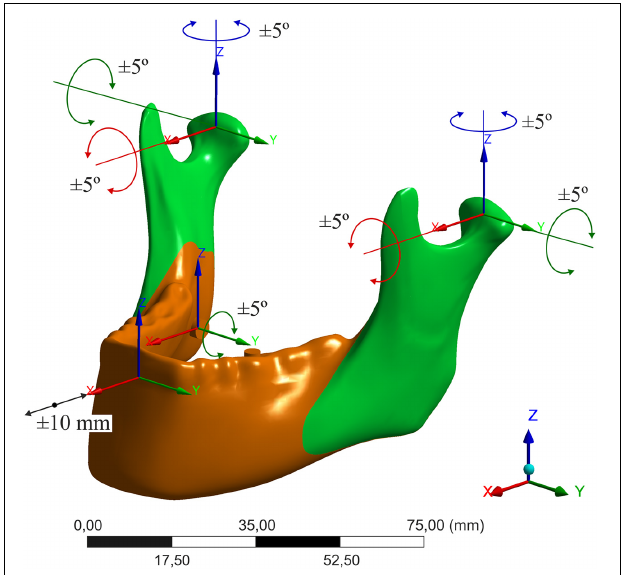
FIGURE 1 | Considered displacements of bone